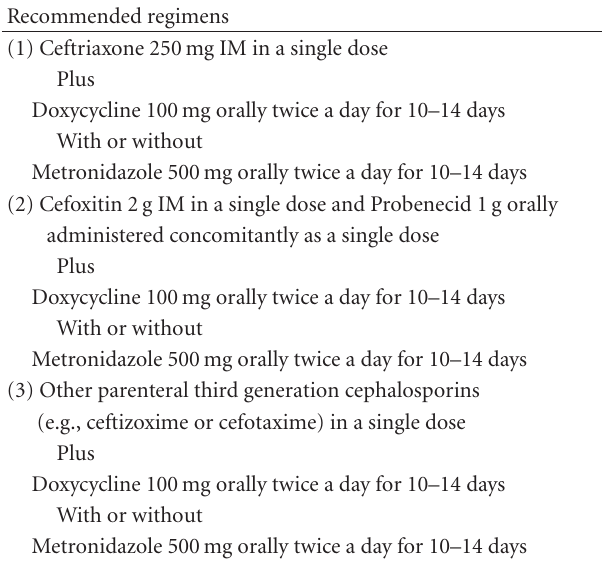
Table 3: Oral treatment recommendations for acute pelvic inflam- matory disease a